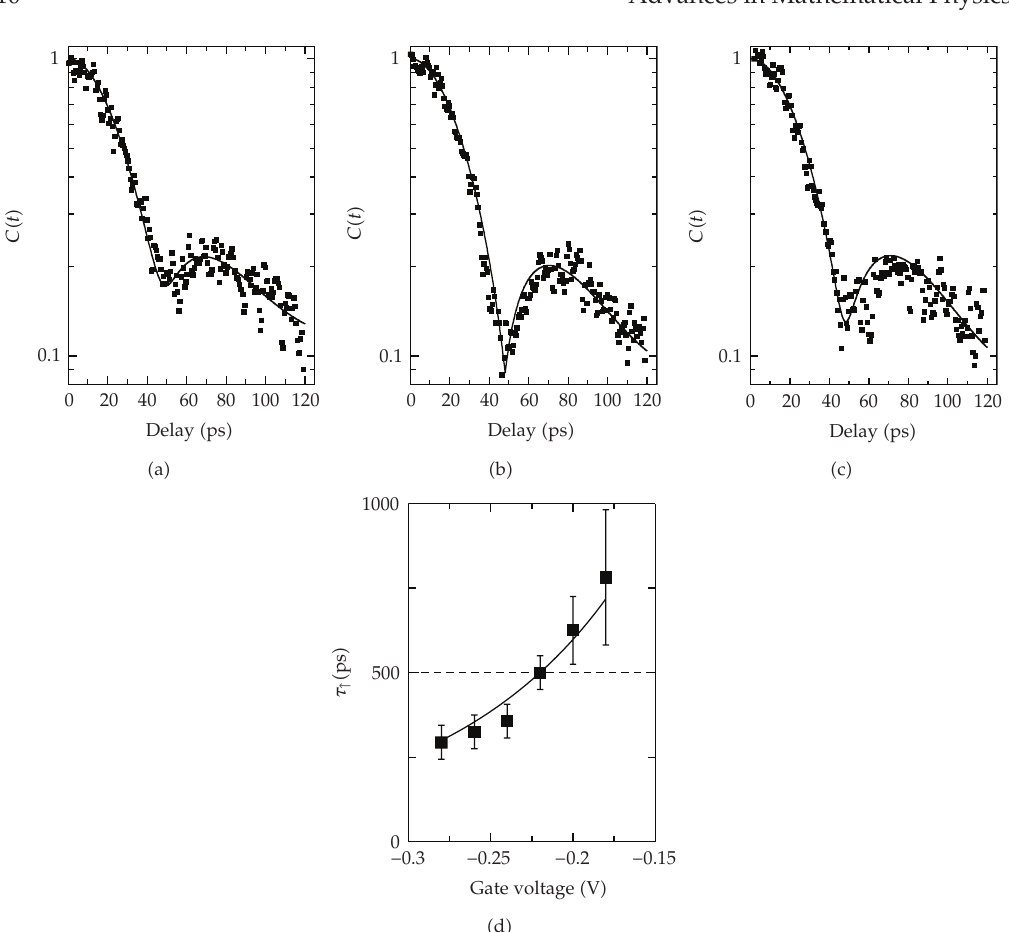
Figure 5: (cid:5) a (cid:6) , (cid:5) b (cid:6) , (cid:5) c (cid:6) : Interferogram contrast C (cid:5) t (cid:6) of the photoluminescence signal of a single InGaAs QD at 10K, on semilogarithmic plots, for three gate voltages: − 0 . 24V (cid:5) a (cid:6) , − 0 . 22 (cid:5) b (cid:6) , and − 0 . 2V. Data (cid:5) squares (cid:6) , (cid:5) t (cid:6) | (cid:5) solid line (cid:6) . (cid:5) d (cid:6) : Tunneling time versus gate voltage. Data theoretical fits corresponding to | φ 1 (cid:5) t (cid:6) φ G N (cid:5) symbols (cid:6) , theoretical fit (cid:5) solid line (cid:6) . The horizontal line indicates the capture time τ ↓ (cid:8)